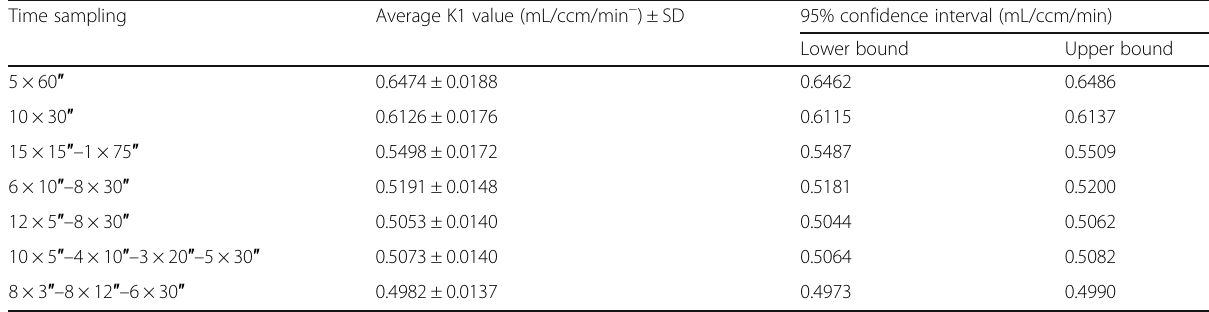
Table 1 Comparison of the K1 values from the 1000 simulations (Monte Carlo) using the same IDIF for the seven different time